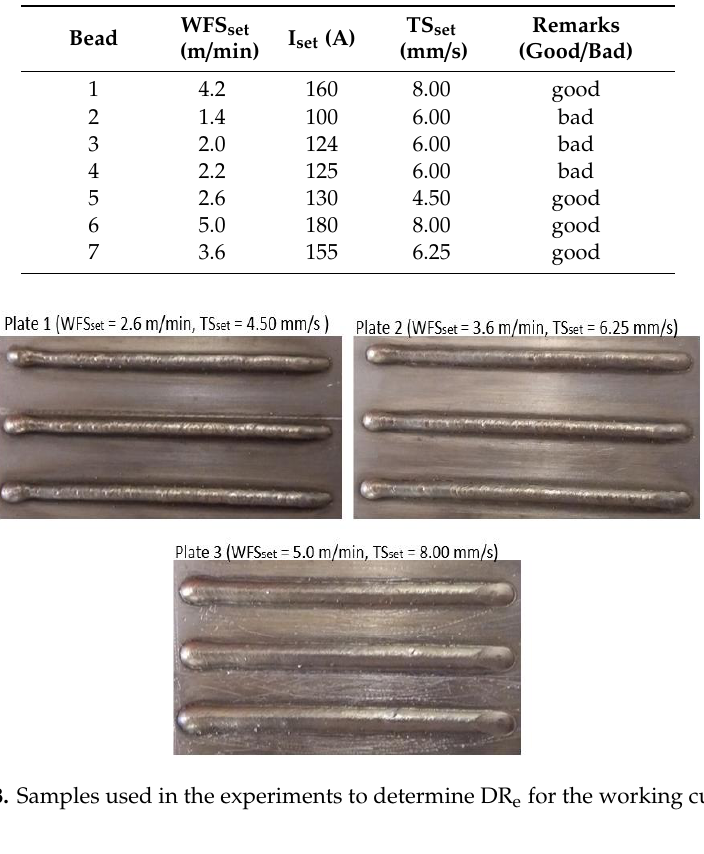
Table 3. Data from workable current range determination.